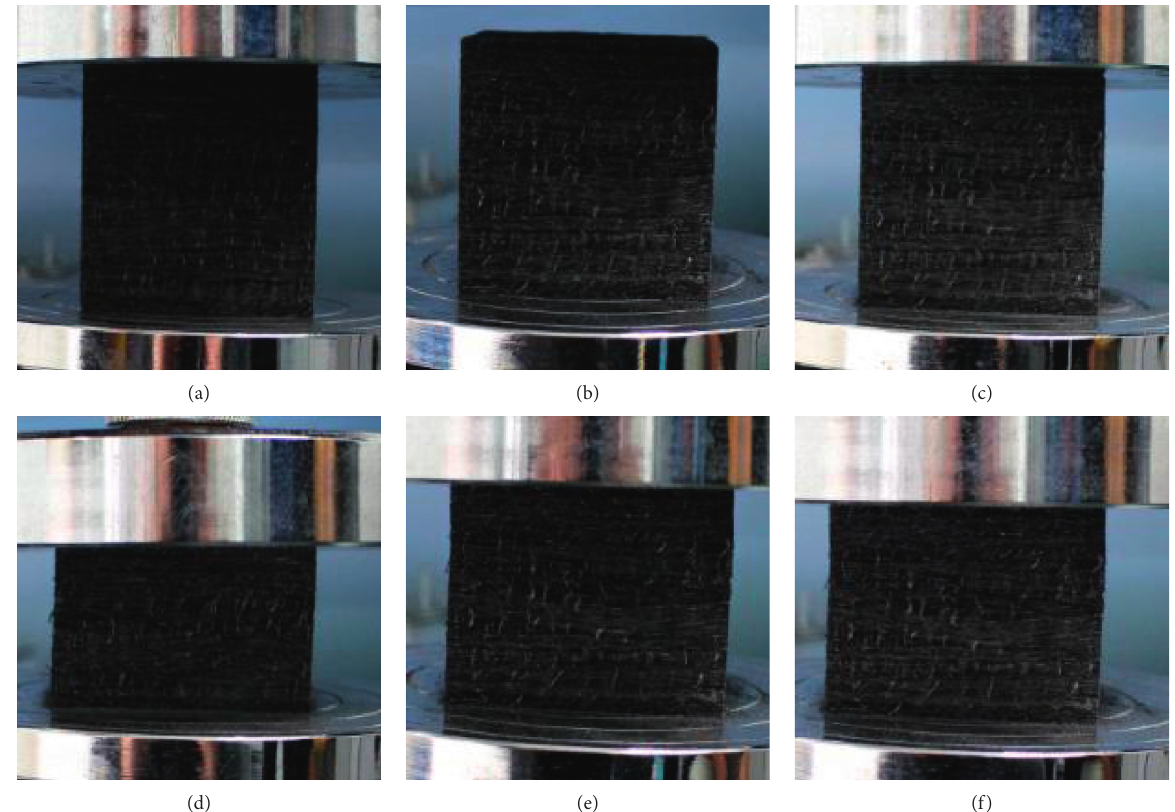
Figure 13: Repeated front compression failure process diagrams of carbon/carbon fiber